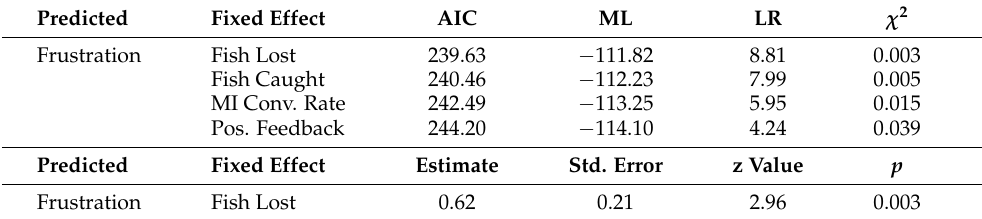
Table 5. (Top) Results of significant likelihood ratio tests predicting frustration. (Bottom) fixed effect estimates for predicting frustration in the best model “Fish